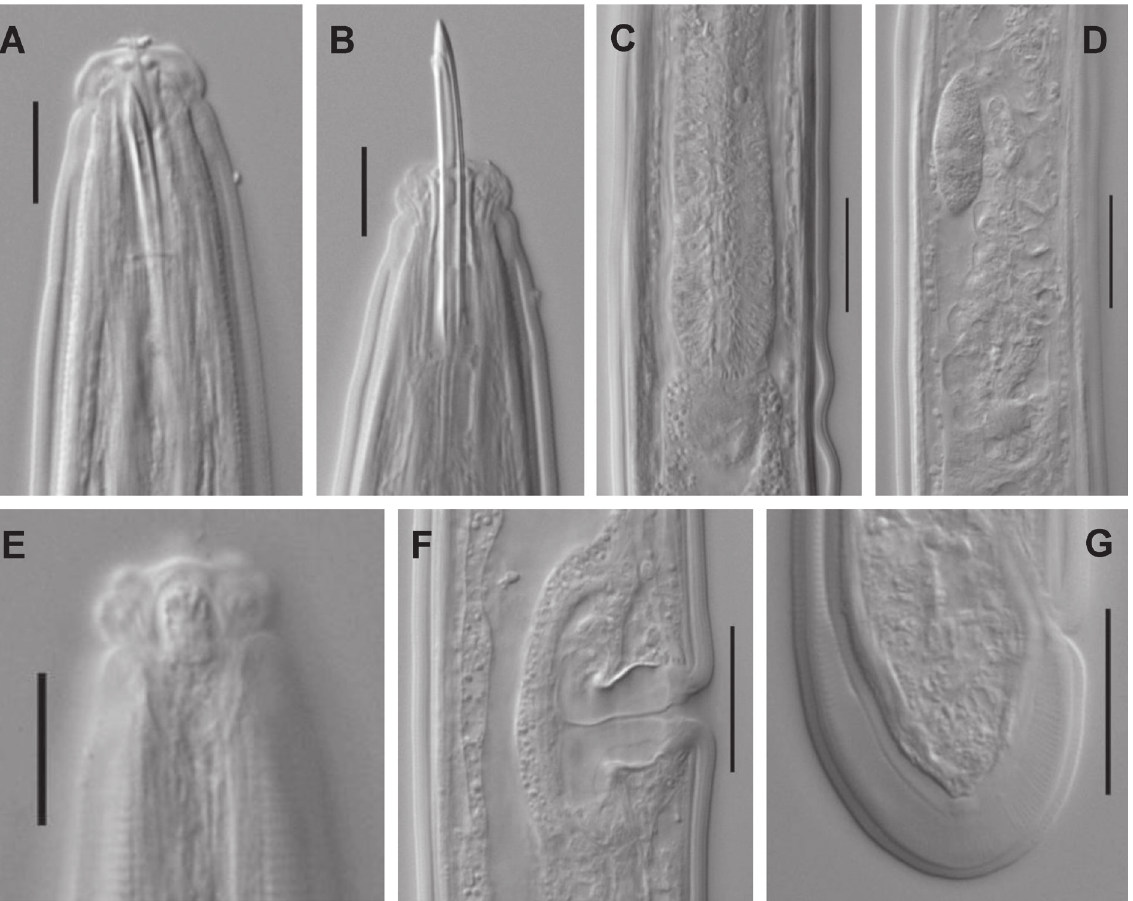
Fig. 2. Pungentus clavatus Ahmad & Jairajpuri, 1979 (♀, LM). A-B . Anterior region in lateral median view. C . Pharyngo-intestinal junction. D . Dorsal cell mass at level of uterus. E . Anterior region in lateral surface view. F . Vagina. G . Caudal region. (Scale bars: A, B, E = 20 µm; C, D, F, G = 10